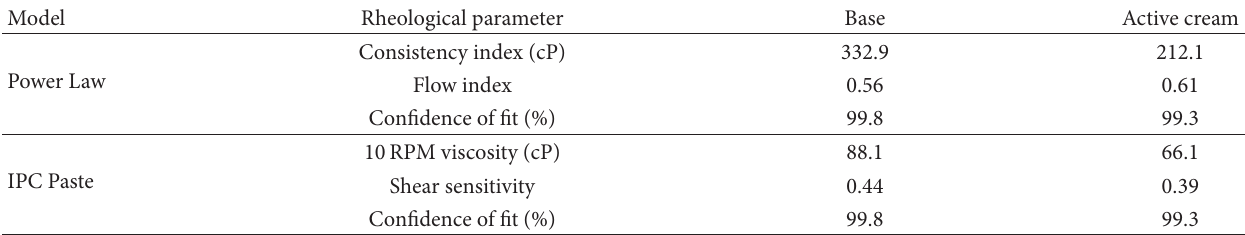
T 2: Rheological parameters of freshly prepared base and active cream.